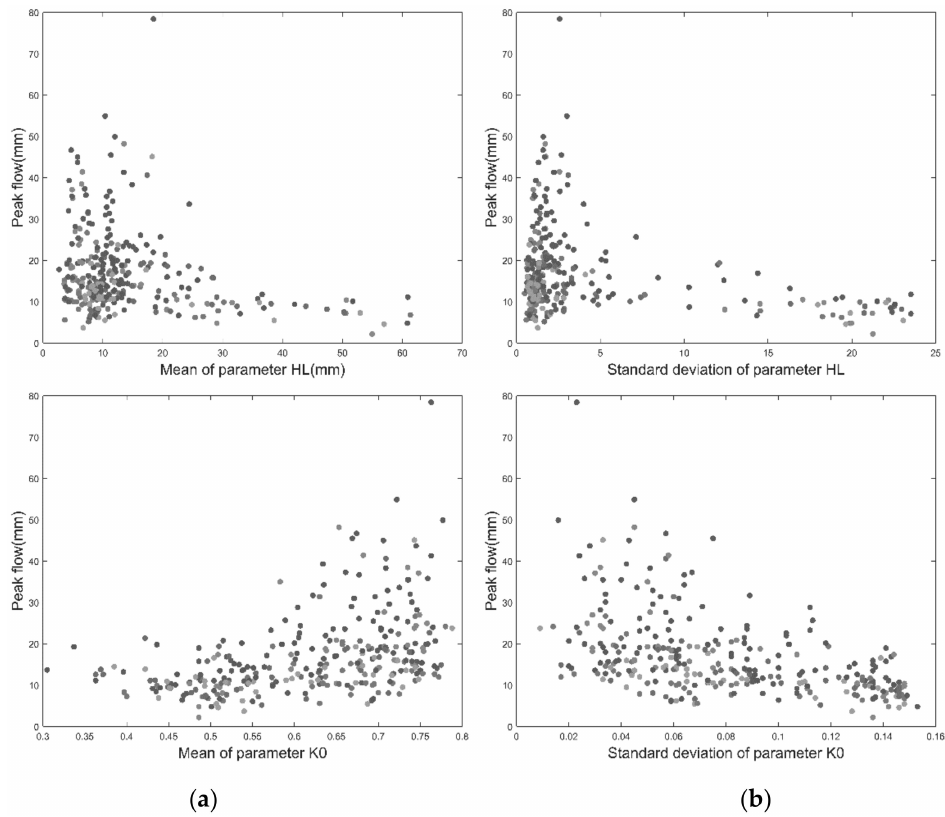
Figure 6. Comparison of peak flow value and the statistical values of parameters (upper figures) threshold water lever ( HL ) and (lower figures) residence time ( K0) . ( a ) Mean value; ( b ) standard